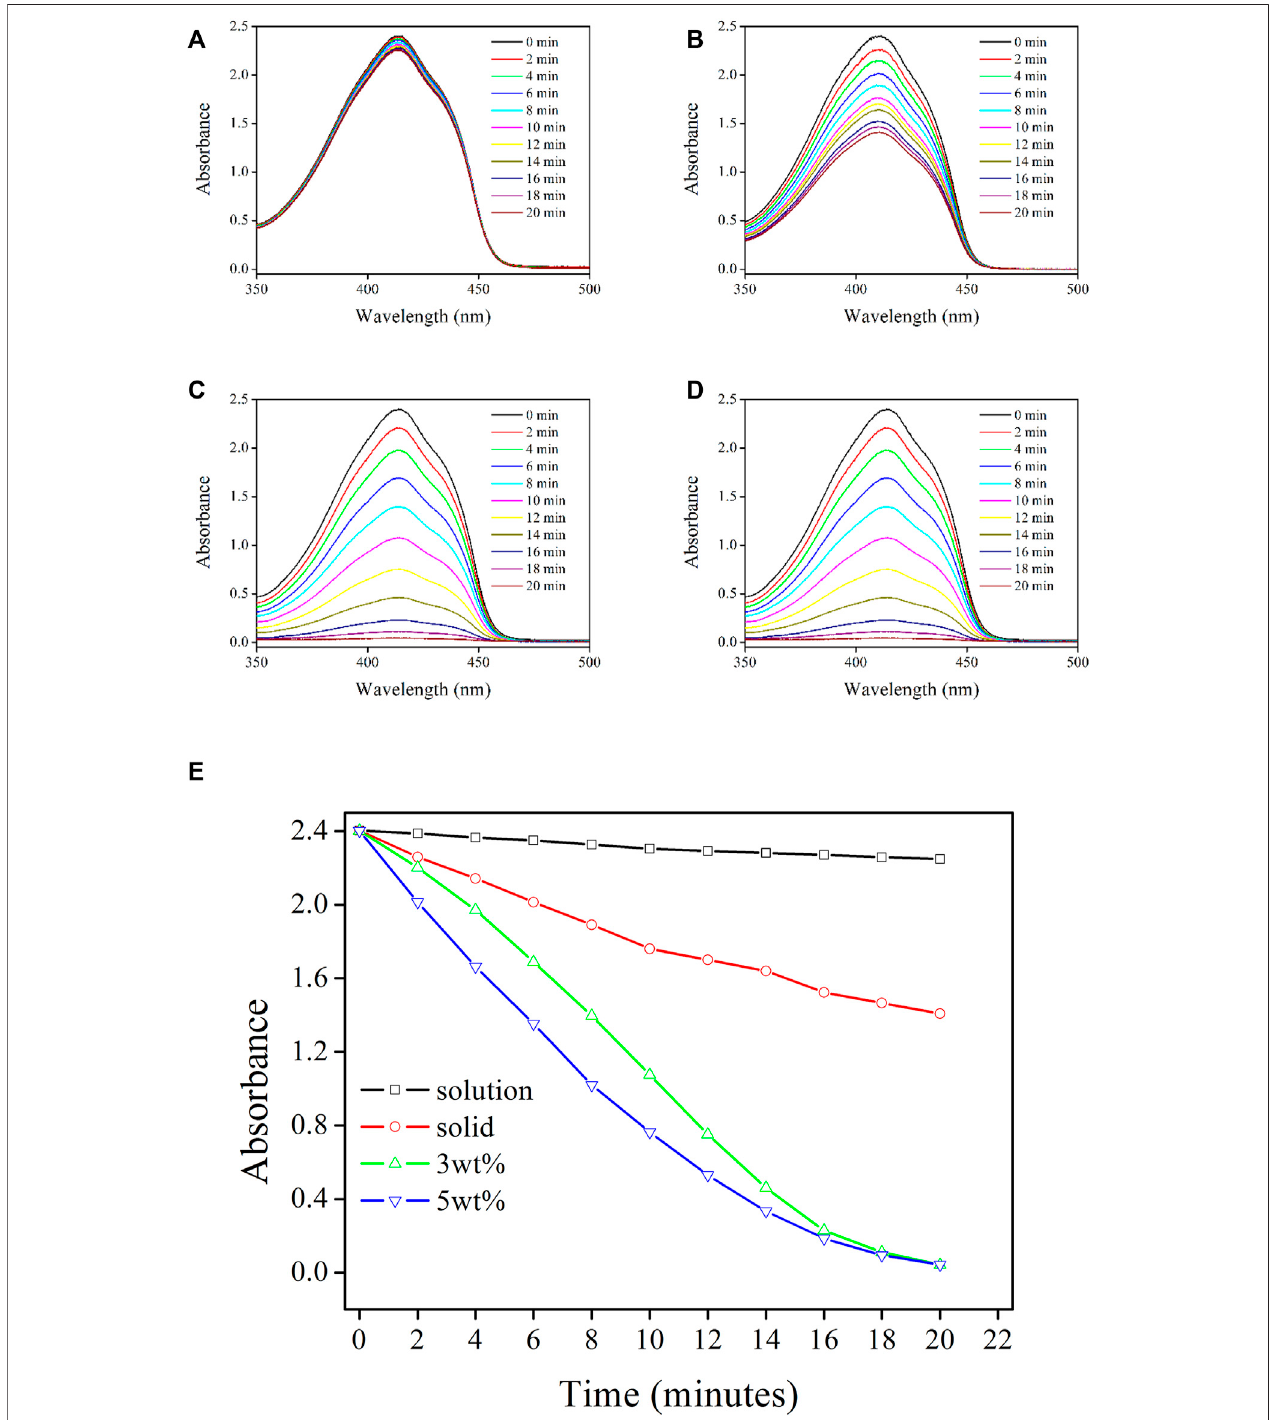
FIGURE 5 | Absorption spectra of DPBF solution being treated by following samples: Re-Gd in solution (A) and solid state (B) , Re-Gd@PVP [3 wt%, (C) and Re- Gd@PVP (5 wt%, (D) ], along with their absorbance variation monitoring (E) .